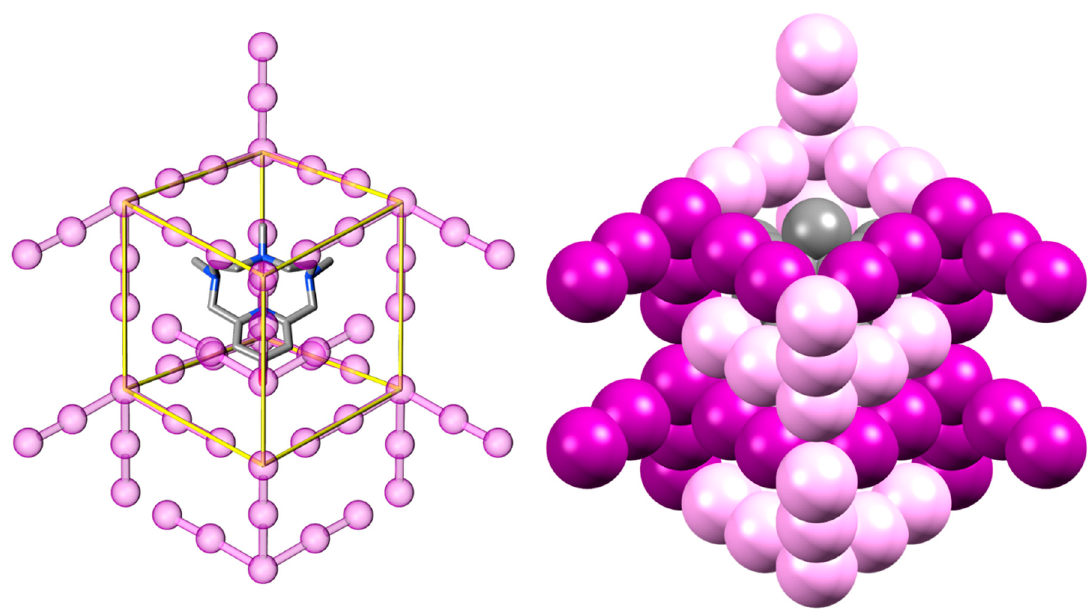
Figure 8. I···I contacts found among the central atom of I 7 − B (highlighted in purple) and neighboring heptaiodides. Short secondary bonds are found linear according to σ -hole type interactions (black solid lines), longer contacts do not respect such geometry (red dotted line).